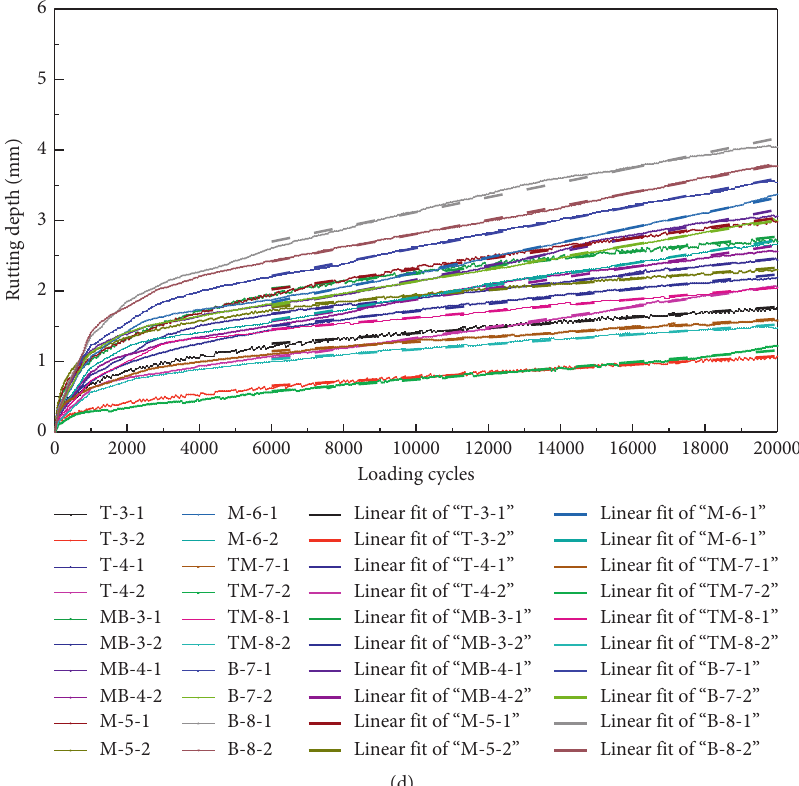
Figure 7: Rutting curves for varying specimens under different test conditions: (a) 50 ° C-water; (b) 60 ° C-dry; (c) 55 ° C-water; (d) 65 °